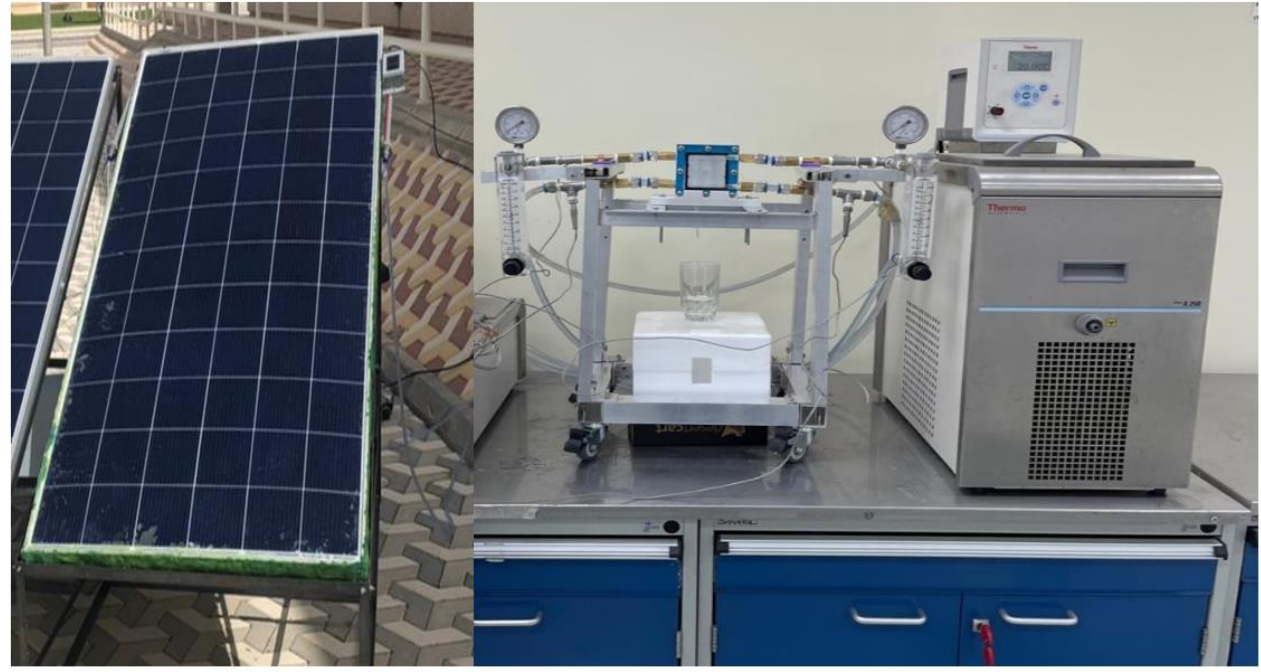
Figure 5. Experimental setup.